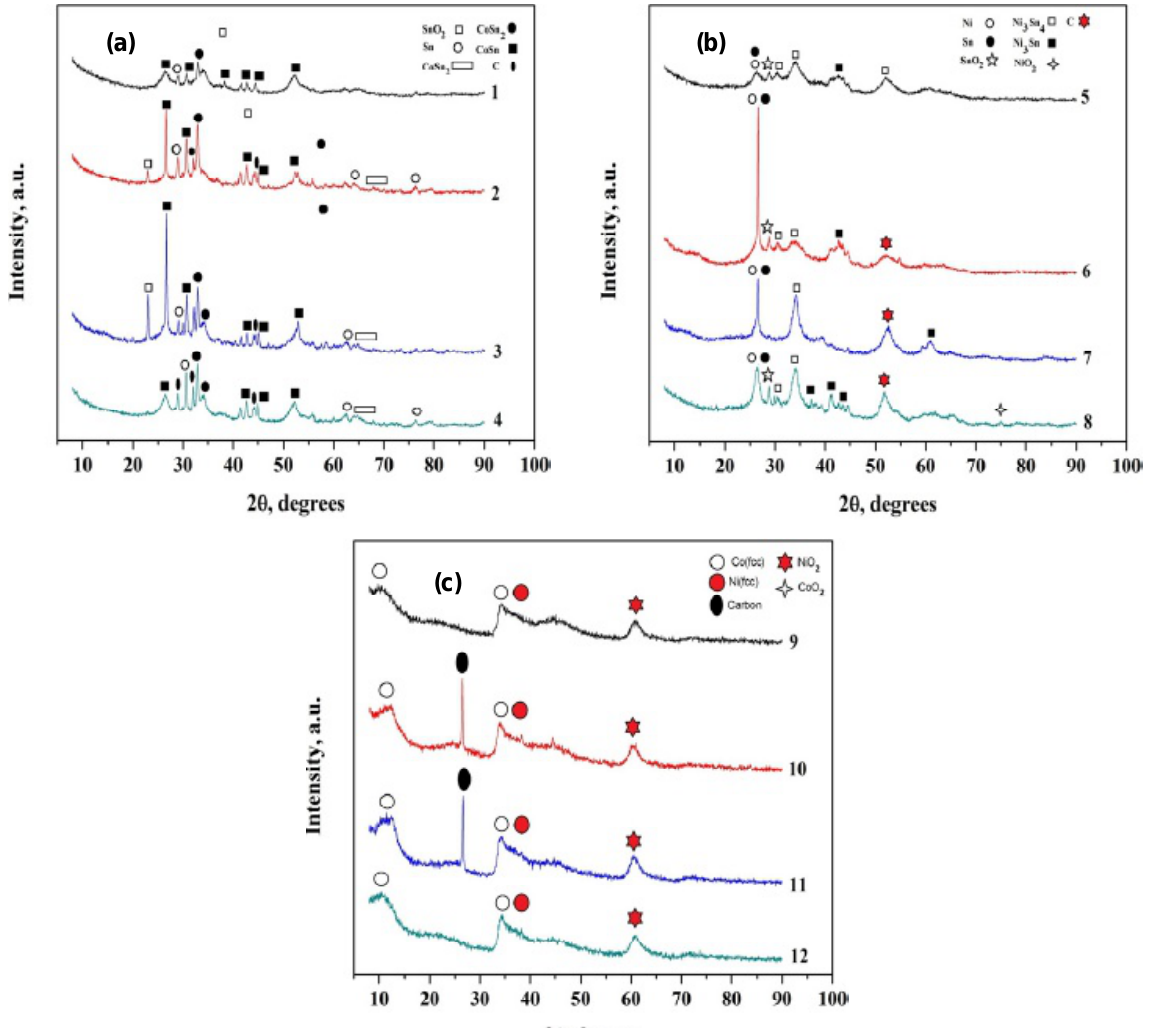
Fig. 5. XRD spectra of the investigated samples: a-Co-Sn nanoparticles/Co:Sn=35:65 (sample 1), Co-Sn/ CF composite (sample 2), Co-Sn/CF/  -CDx composite (sample 3), Co-Sn/C-powder composite (sample 4); b-Ni-Sn nanoparticles/Ni:Sn=45:55 (sample 5), Ni-Sn/CF composite (sample 6), Ni-Sn/CF/  -CDx com- posite (sample 7), Ni-Sn/C-powder composite (sample 8); c-Co-Ni nanoparticles/Co:Ni=50:50 (sample 9), Co-Ni/CF composite (sample 10), Co-Ni /CF/  -CDx composite (sample 11), Co-Ni/C- powder composite (sample